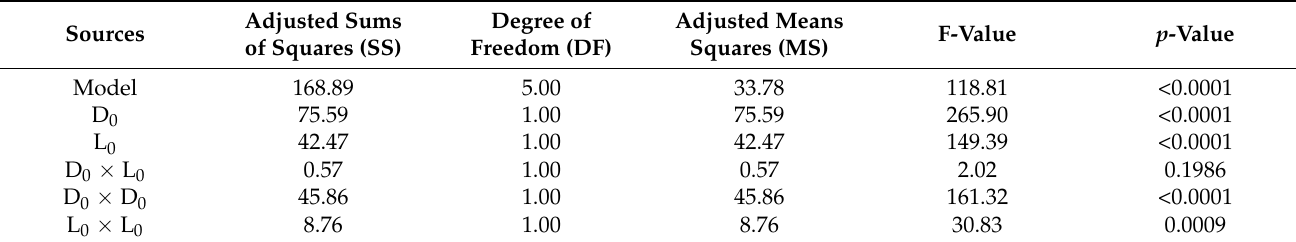
Table 4. Error analysis.